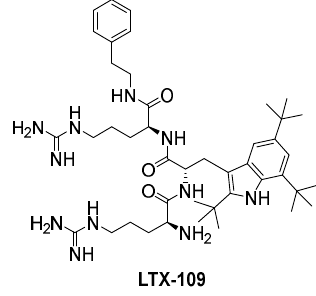
Figure 1. Structure of LTX-109.